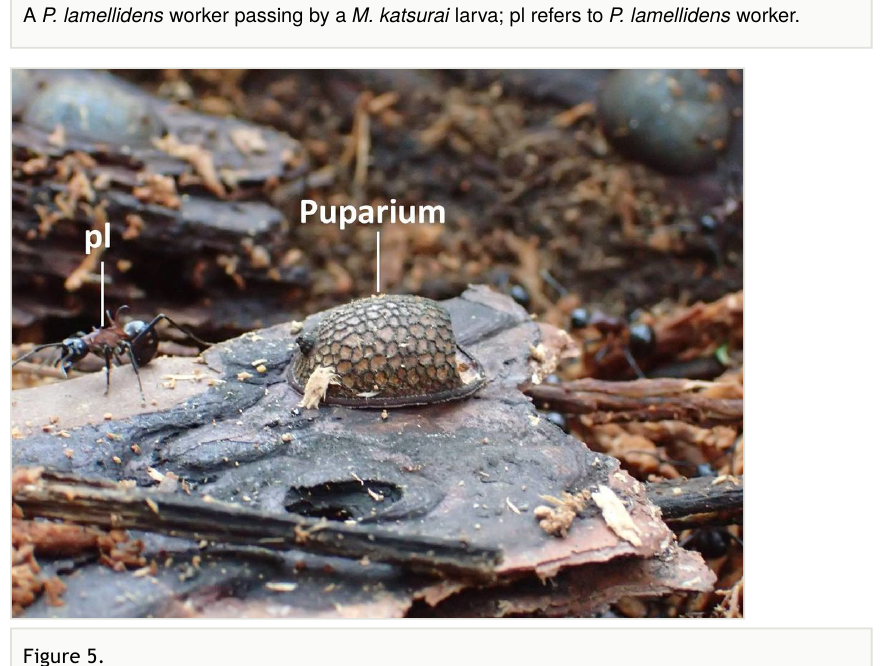
Figure 5. Puparium of M. katsurai with a P. lamellidens worker; pl refers to P. lamellidens